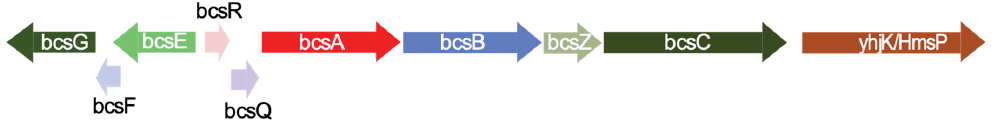
Figure 1. Schematic representation of genes involved in cellulose metabolism present in S. turicensis .